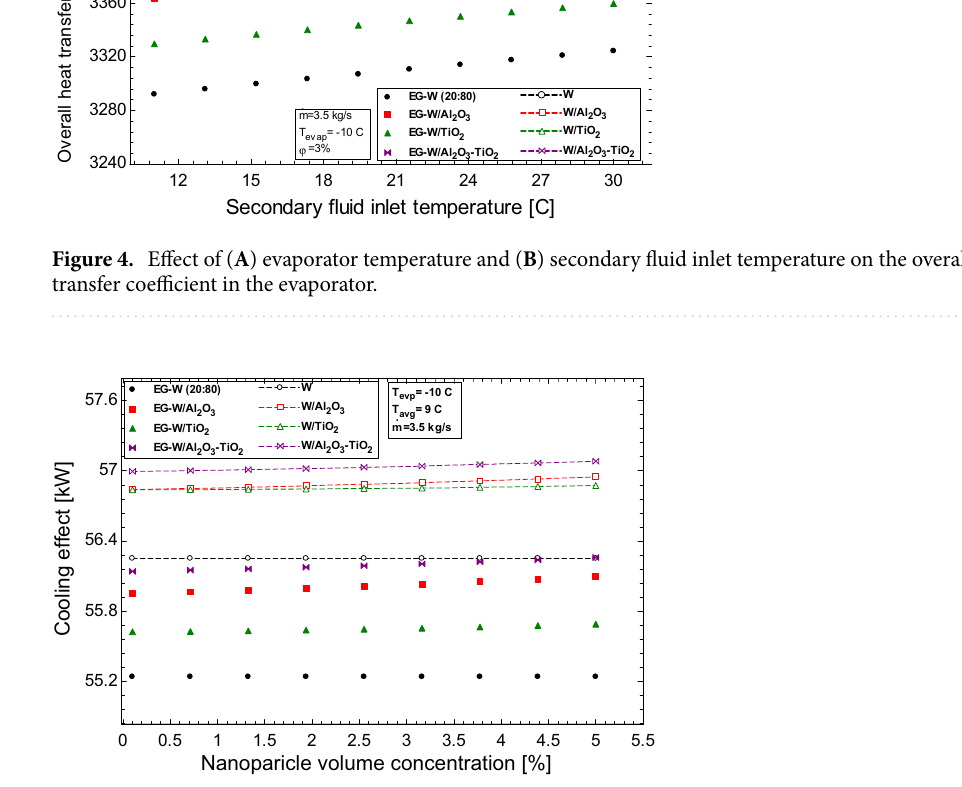
Figure 5. Effect of nanoparticle volume concentration on the cooling effect of the